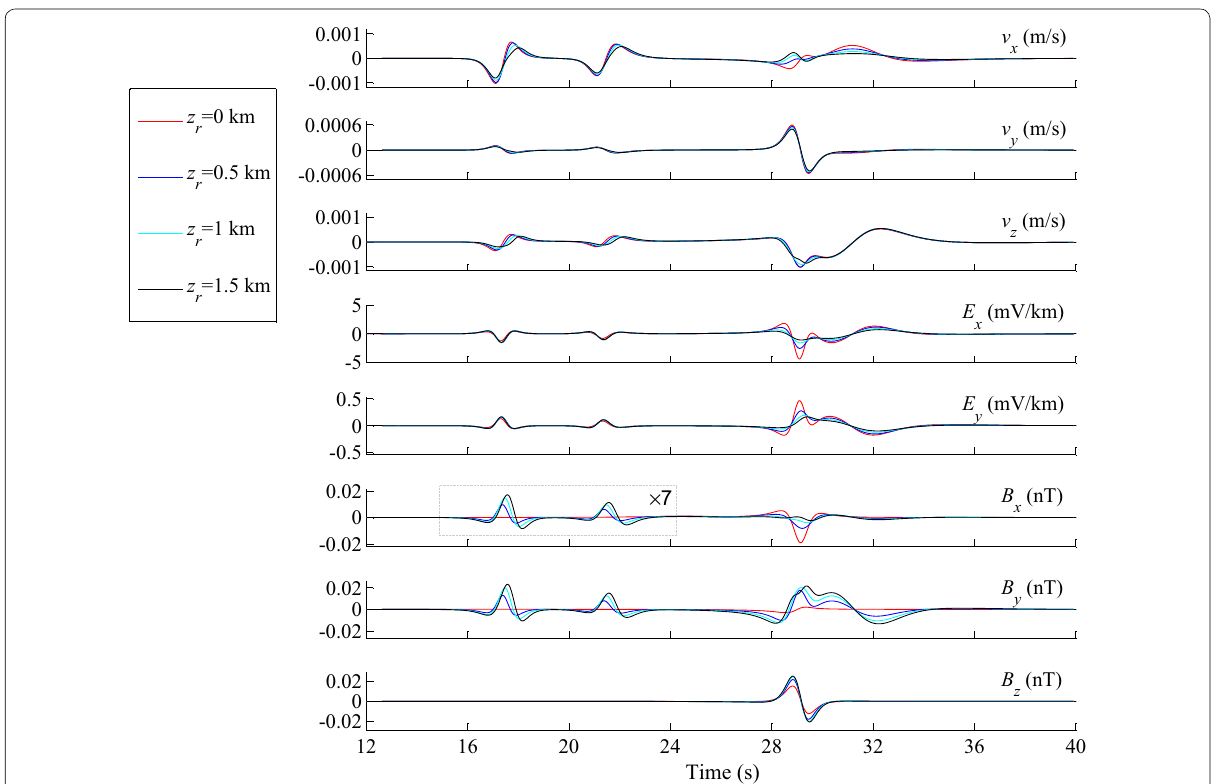
Fig. 5 Seismic and EM signals calculated for four different receivers in the water‑saturated half‑space porous model. These four receivers have different depths z r 0, 500, 1000 and 1500 m but the same lateral offset x r = a factor of 7 to improve the